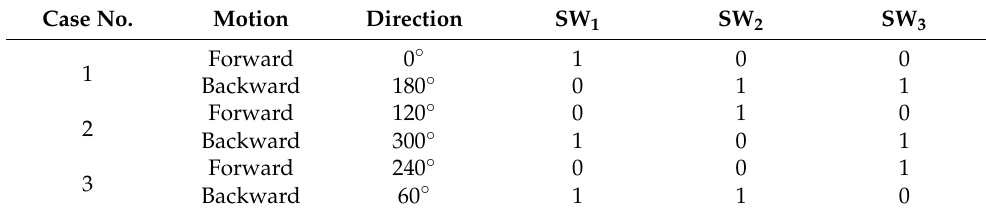
Table 2. Switch positions for motion direction control. Case